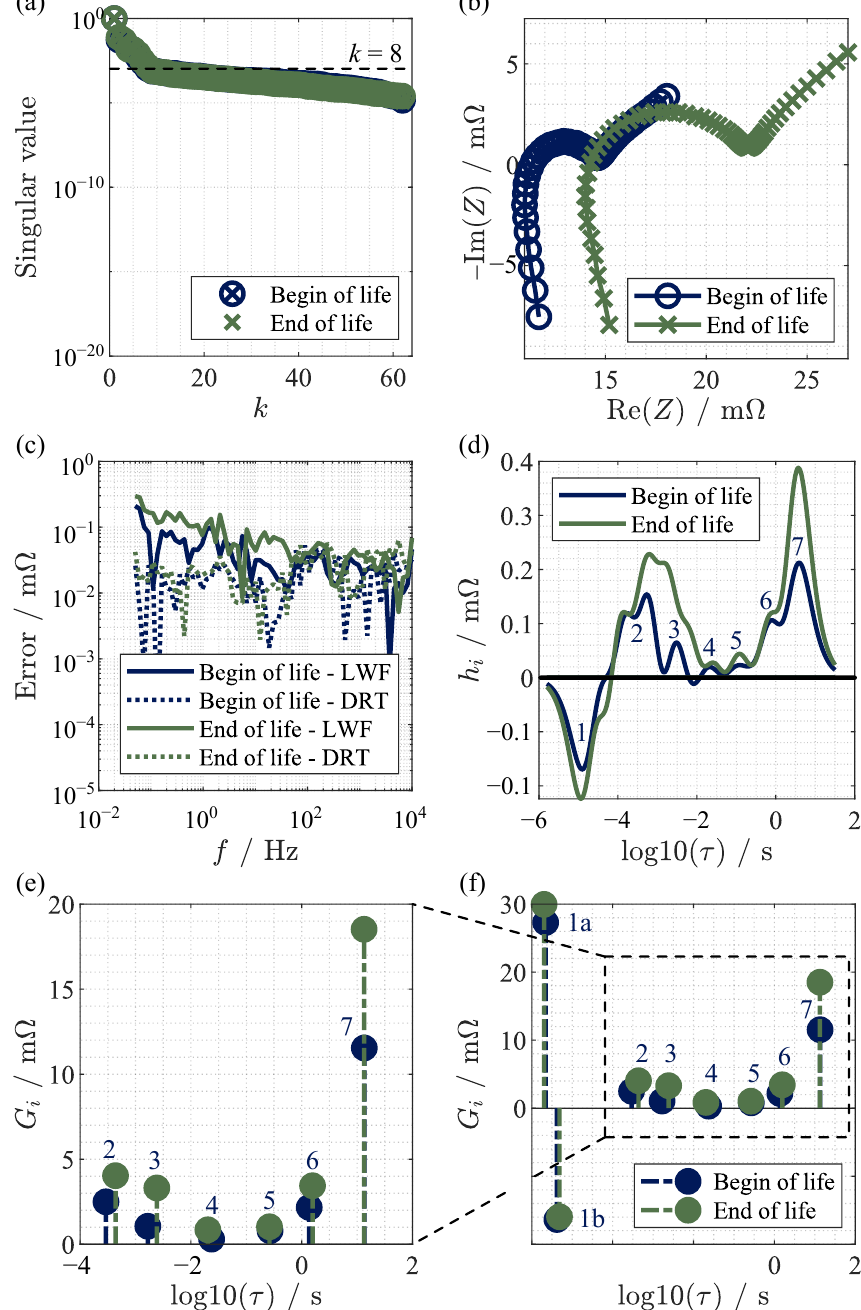
Figure 7. SVD ( a ), Nyquist plot ( b ), error of magnitude ( c ), DG ( d ), zoom of the distribution of gains ( e ), distribution of gains ( f ) for the BOL and EOL